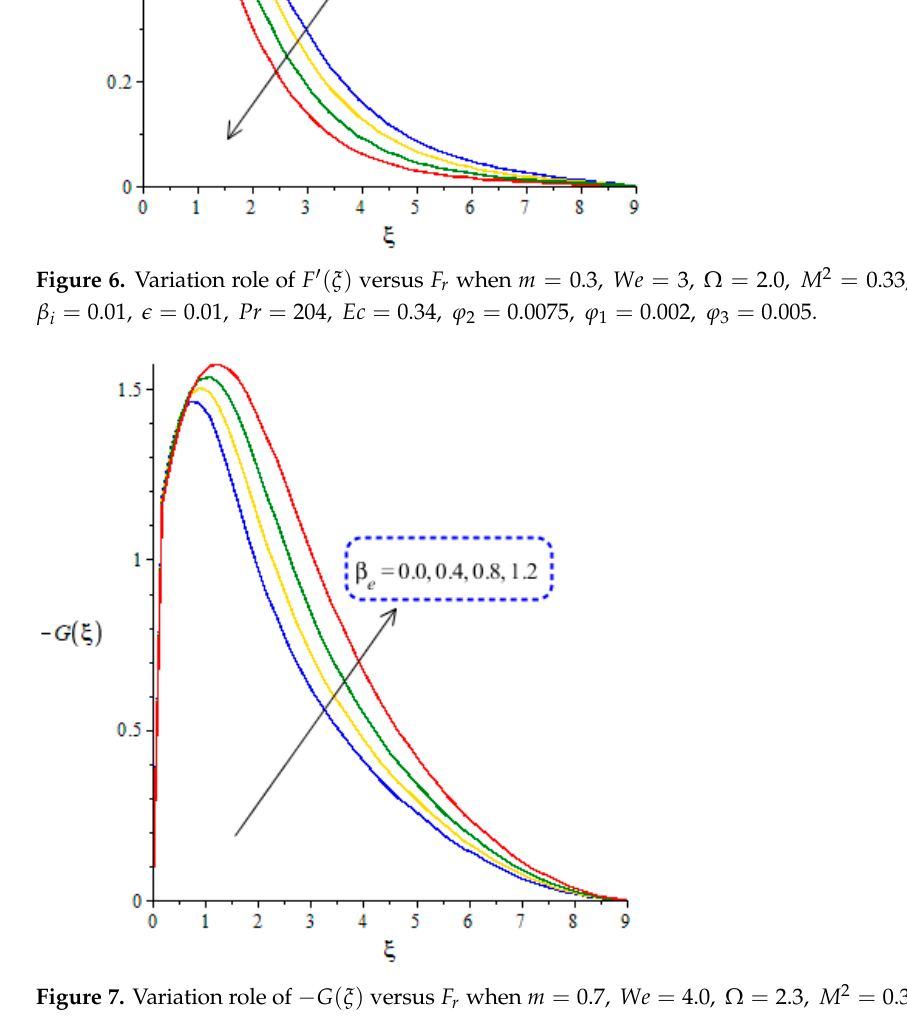
Figure 8. Variation role of 𝐹′(𝜉) versus 𝐹 (cid:3045) when 𝑚 = 0.01, 𝑊𝑒 = 5, Ω = 2.0,𝑀 (cid:2870) = 0.5,𝛽 (cid:3036) = 0.3, 𝜖 = 0.1, 𝐹 (cid:3045) = 2.7,𝑃𝑟 = 204,𝐸𝑐 = 0.14, 𝜑 (cid:2870) = 0.0075, 𝜑 (cid:2869) = 0.002, 𝜑 (cid:2871) = 0.005.